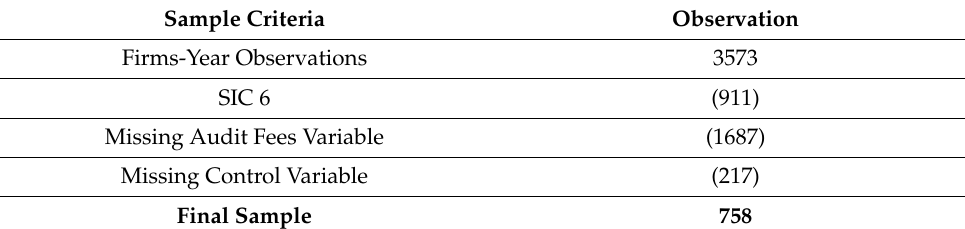
Table 2. Derivation of